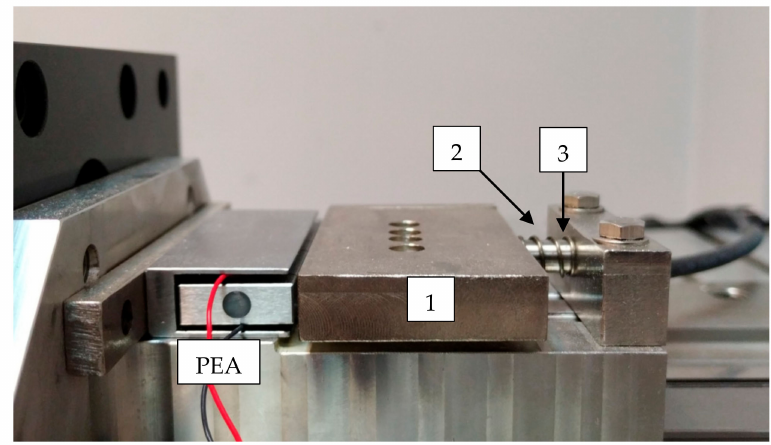
Figure 1. Positioning system setup: (1) main body, (2) spring holder, and (3) pin fixture.